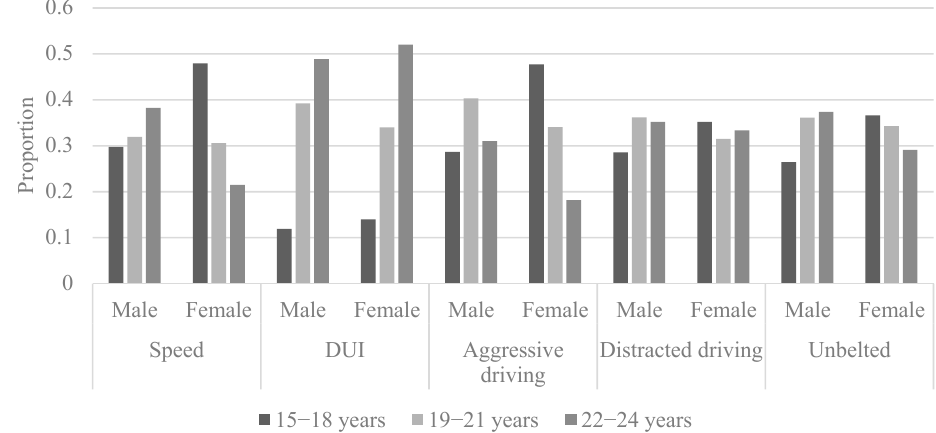
Figure 3. Gender and age subgroup comparison of behavior related crash factors.